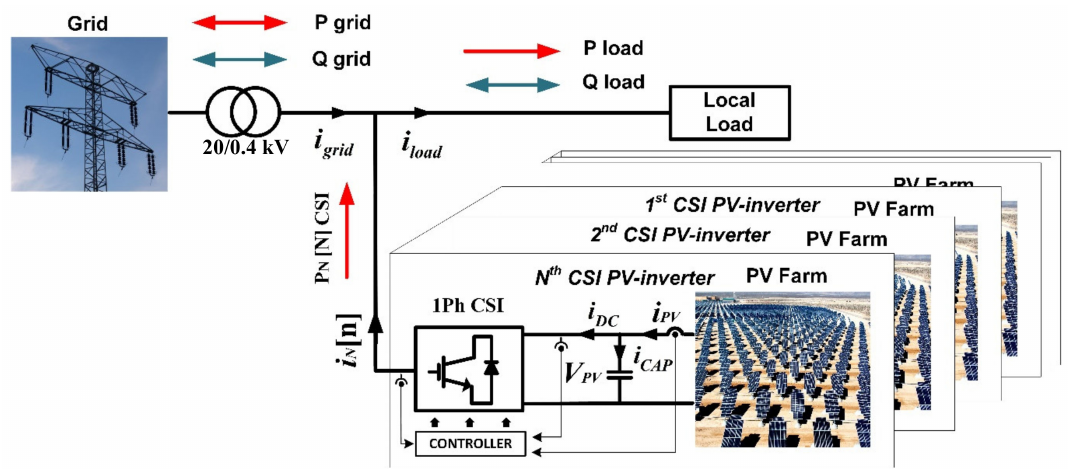
Figure 2. Schematic diagram of the system under study, where PV-distributed energy resources (DER) generators have been used.